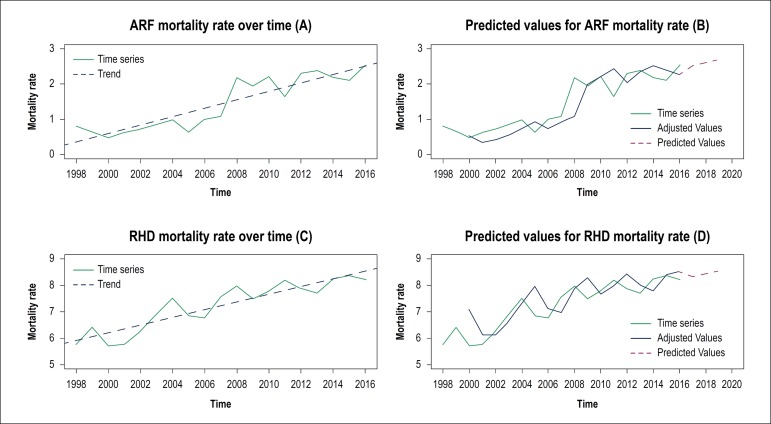
Growth trends and predicted values for Acute Rheumatic Fever (ARF) and
Rheumatic Heart Disease (RHD) mortality rates. The model equation for
the trend of the ARF (A) mortality rate was ARFMT = –237,79 +
0,12* Year, whereas for the trend of the RHD mortality rate (C) it was
RDHMT = –286,11 + 0,15* Year. It should be noted that all
trends were significant (p-value < 0.050), evidencing the increasing
trend of the series over time.